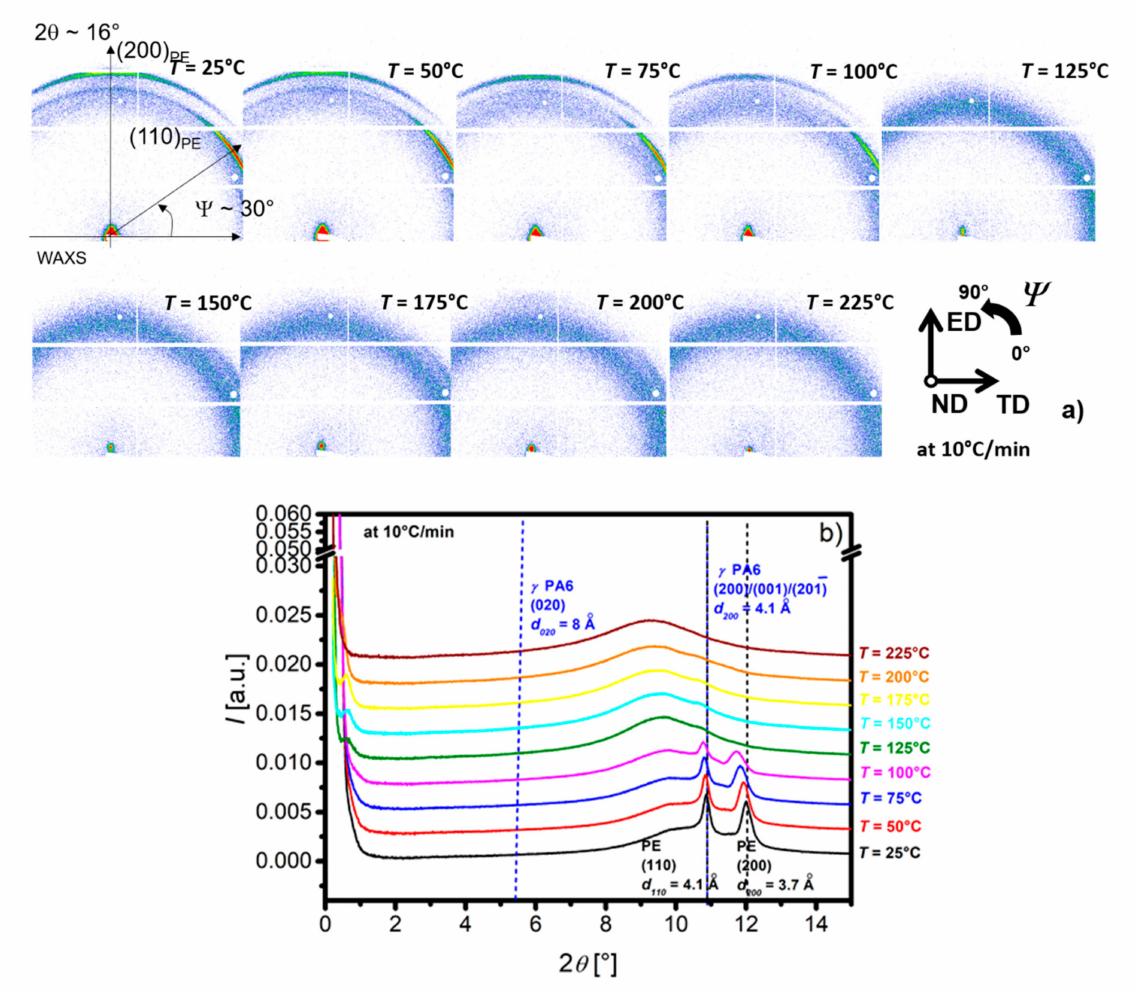
Figure 4. 2D WAXS of 8 LME PE/PEgMA/PA6 multilayer films in normal direction (ND) at different temperatures T. ( a ): 2D-patterns, ( b ): 1-D Diffractograms obtained after azimuthal